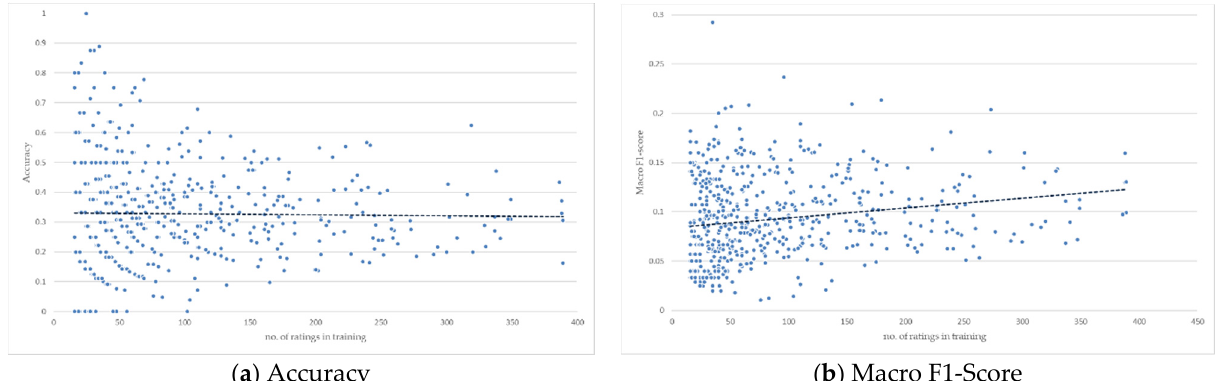
Figure 22. Average macro F1-score comparison of our proposed approach with the other ap- proaches.